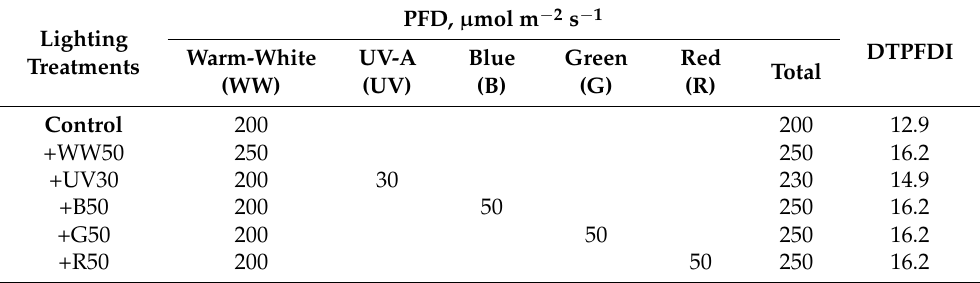
(Table 2). The PFD of each color channel was controlled at a 1 µ mol m − 2 s − 1 increment using proprietary software (Spartan Control Software; OSRAM, Beverley, MA, USA). Three LED fixtures (67.3 × 29.8 × 4.3 cm each) were positioned 47 cm above each raft and spaced on 41-cm centers to achieve reasonably good PFD uniformity. Lighting treatments consisted of 200 µ mol m − 2 s − 1 of WW light (control) without or with an additional 30 µ mol m − 2 s − 1 of UV-A (+UV30) or 50 µ mol m − 2 s − 1 of WW, B, G, or R light (+WW50, +B50, +G50, or +R50, respectively) for 18 h d − 1 (Table 2). The photon distributions of all lighting treatments were measured using a portable spectroradiometer (PS200; Apogee Instruments, Inc., Logan, UT, USA). Table 2. LED types and photon flux densities (PFD) were used to deliver six lighting treatments used in